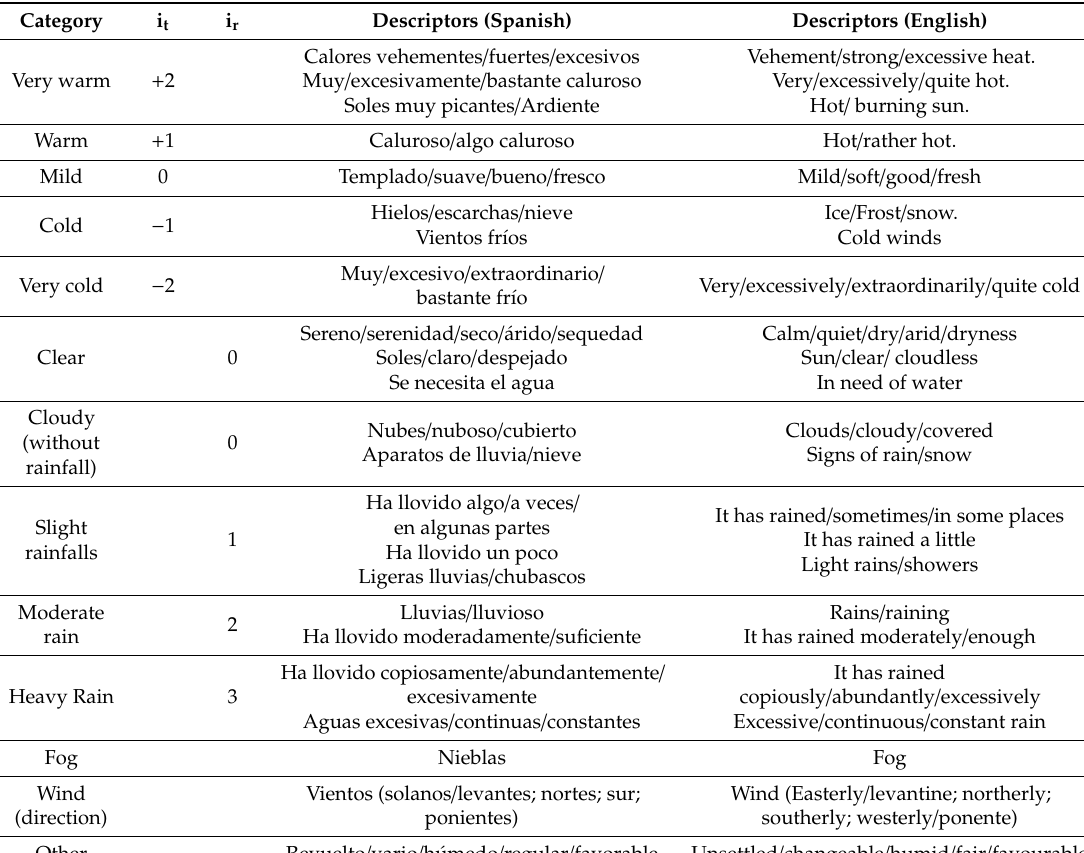
Table 1. Terms used in the CMEI to describe the meteorological events and the assigned indices (i t = temperature index; i r = precipitation